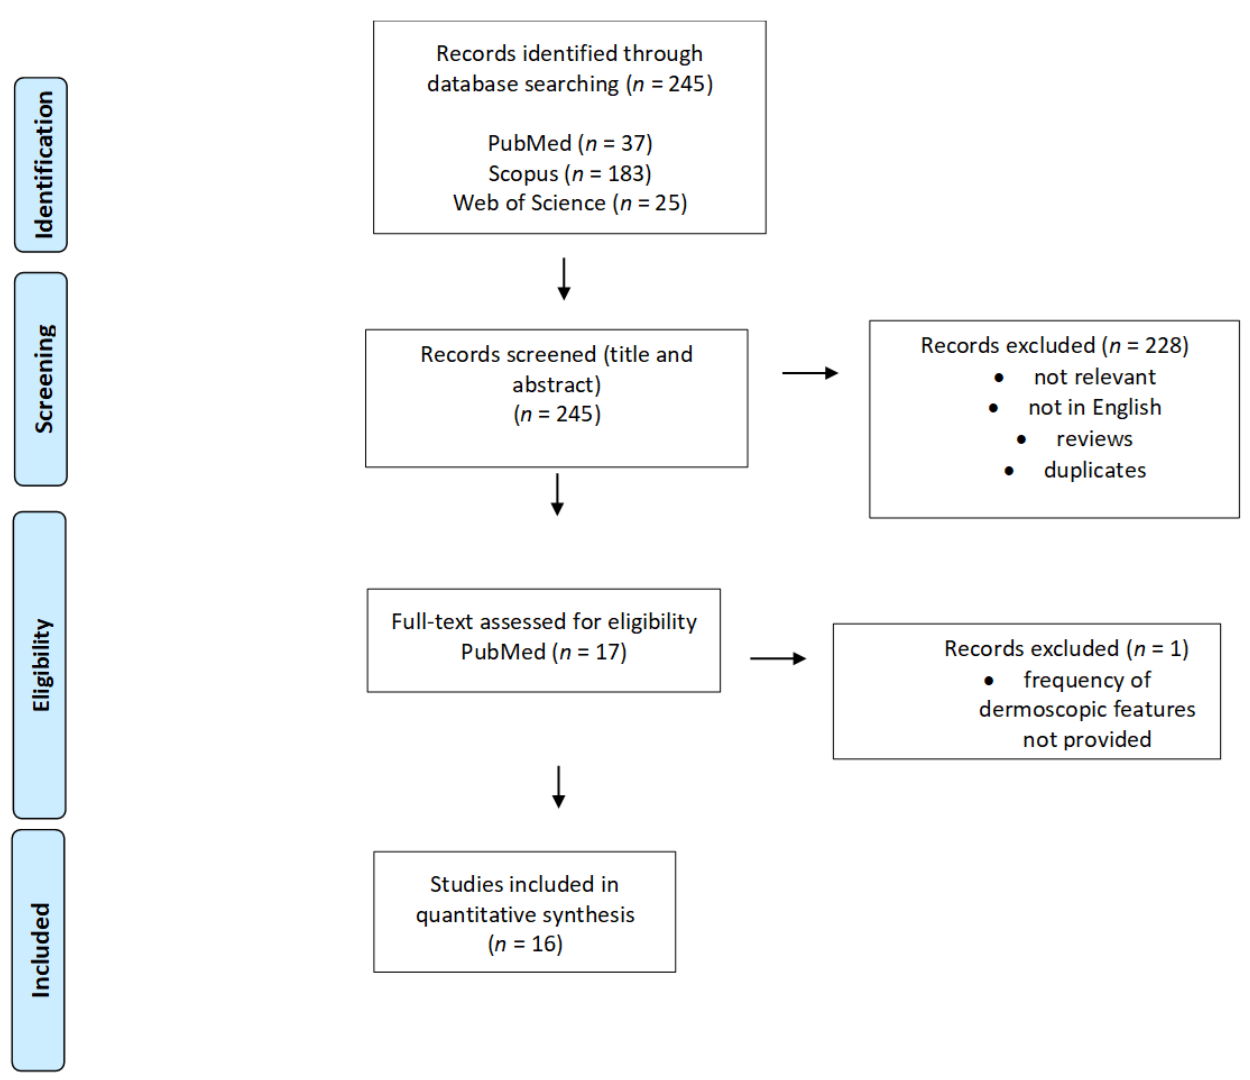
Figure 1. PRISMA flow diagram demonstrating the selection process for study inclusion in the systematic review.